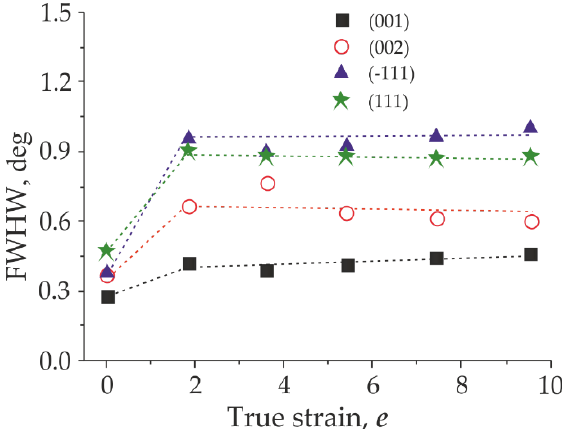
Figure 4. The full-width at half maximum (FWHM) of the most intense B19 ’ peaks versus true abc strain in Ti 49.8 Ni 50.2 .